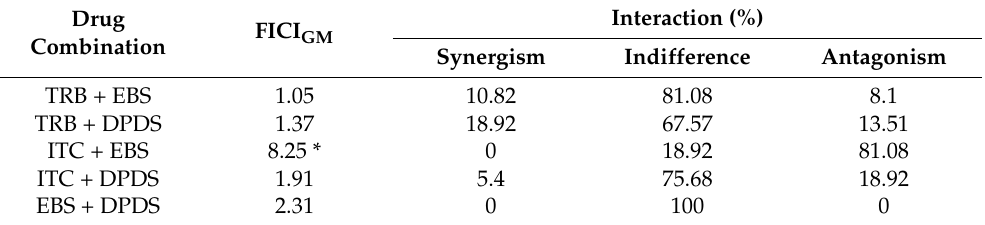
Table 3. The fractional inhibitory concentration index (FICI), and the geometric mean (GM) of interactions between antifungal agents and organoselenium compounds against clinical isolates of Trichophyton mentagrophytes